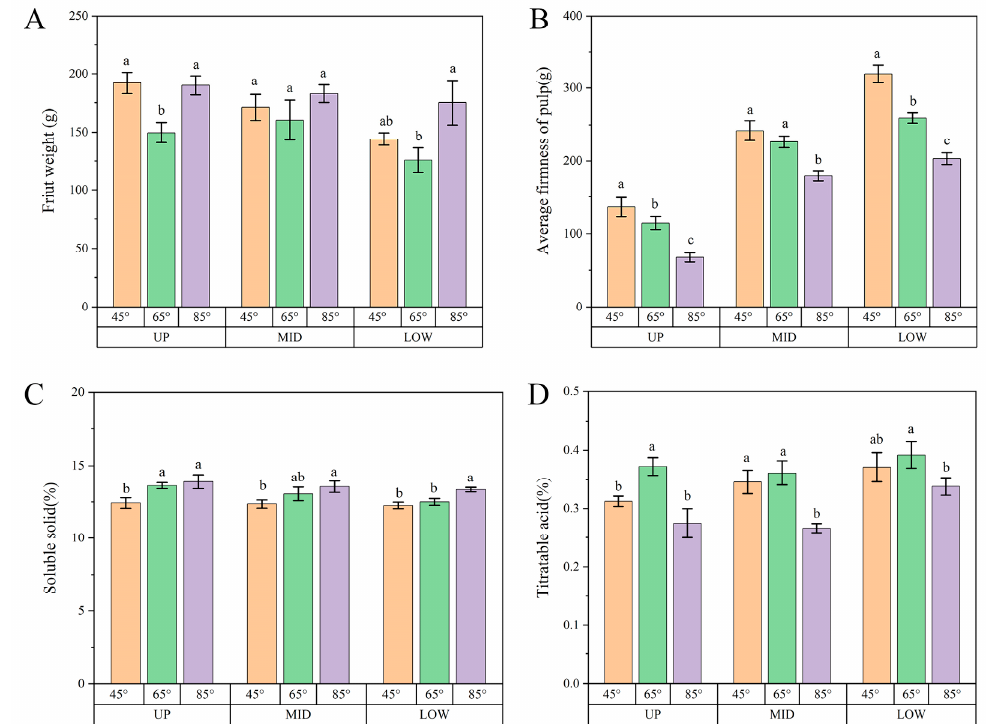
Figure 9. Effects of different main branch base angles on fruits quality in peach. ( A ) Friut weight; ( B ) average firmness of pulp; ( C ) soluble solid; ( D ) titratable acid. Different lowercase letters indicate Figure 9. E ff ects of di ff erent main branch base angles on fruits quality in peach. ( A ) Friut weight; significant differences between treatments ( p < ( B ) average fi rmness of pulp; ( C ) soluble solid; ( D ) titratable acid. Di ff erent lowercase le tt ers indicate signi fi cant di ff erences between treatments ( p < 0.05).